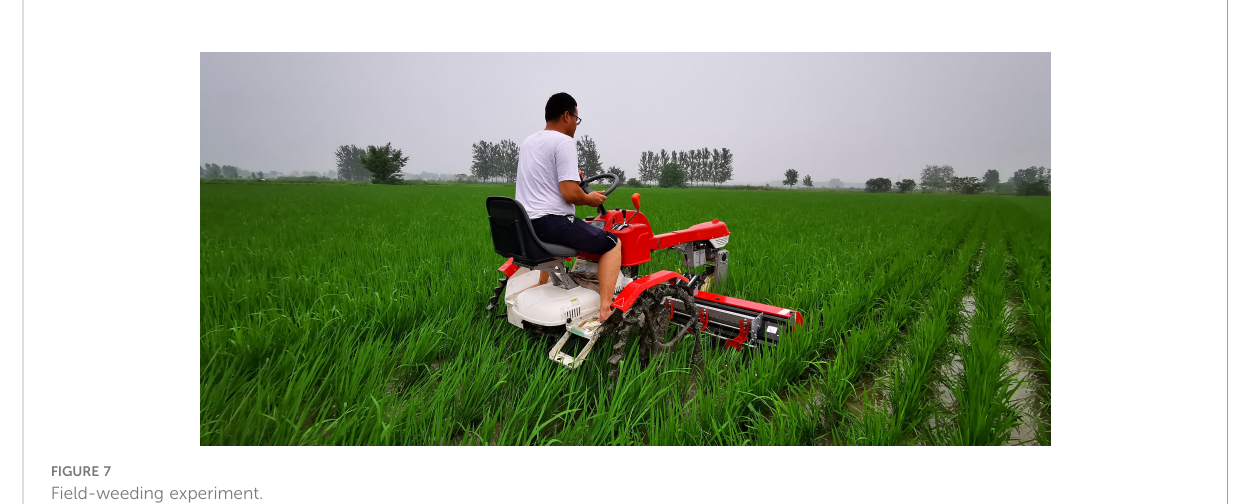
FIGURE 7 Field-weeding